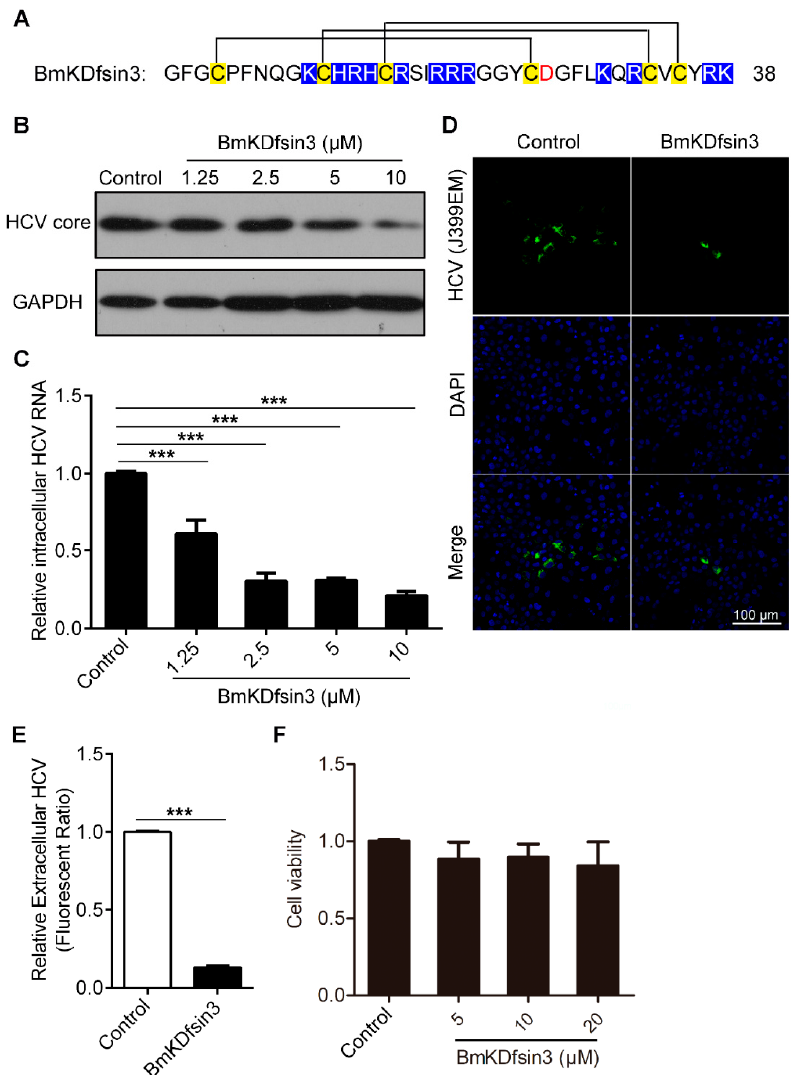
Figure 1. BmKDfsin3 inhibits HCV replication in vitro under noncytotoxic concentrations. ( A ) Amino acid sequence of BmKDfsin3. There are six cysteine residues forming three pairs of disulfide bonds. Cysteine residues are labeled with yellow, basic residues with blue, and acidic residues with red. ( B , C ) Concentration-dependent inhibition of BmKDfsin3 on HCV infection in Huh7.5.1 cells. Huh7.5.1 cells were preincubated with the BmKDfsin3 at di ff erent concentrations for 1 h and then infected with HCV J399EM at an multiplicity of infection (MOI) of 0.1. After 72 h, cells were collected, and intracellular HCV core protein levels were analyzed by western blotting ( B ) and intracellular HCV RNA was analyzed by qPCR ( C ). The J399EM was derived from the JFH-1 virus (HCV genotype 2a strain) by insertion of eGFP into the HCV NS5A region. ( D ) Inhibition of BmKDfsin3 on extracellular virus particles of Huh7.5.1 cells. Huh 7.5.1 cells treated with or without BmKDfsin3 (5 µ M) were infected by J399EM for 72 h, and then supernatant was collected and used to incubate naïve Huh7.5.1 cells for 72